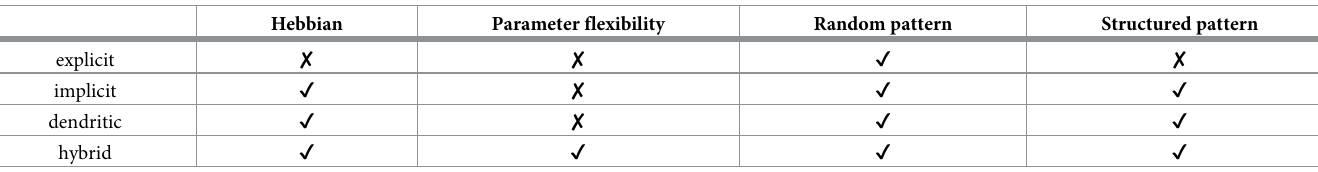
Table 1. Summary of covPCNs discussed in this